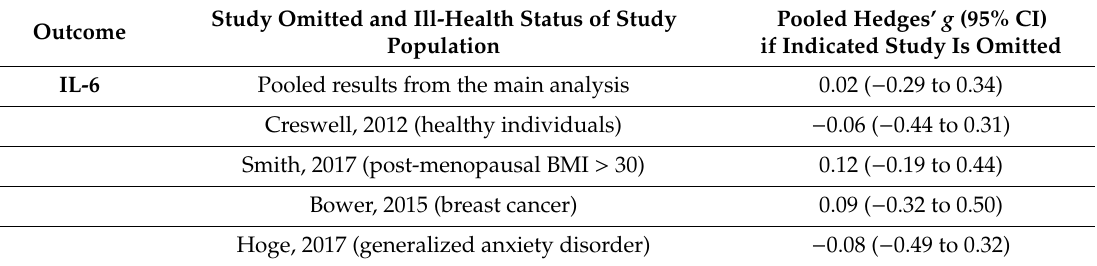
Table A1. Leave-one-out analysis for each specific outcome and sensitivity analysis by ill-health status of the study